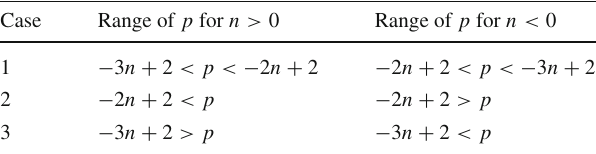
Table 1 Allowed ranges of p depending value of n whereas V 0 > 0 in case 1 and V 0 < 0 in cases 2 and 3 Case Range of p for n > 0 Range of p for n < 0